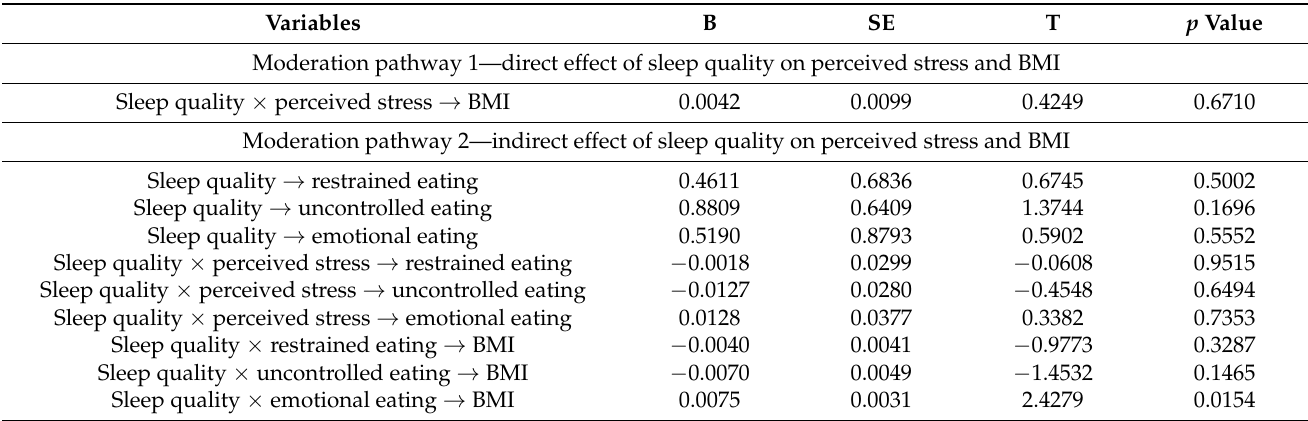
Table 10. Model A moderation analysis (sleep quality as a moderator) for females.